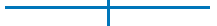
Figure 3 . Chambers in the space of real mass parameters ( m